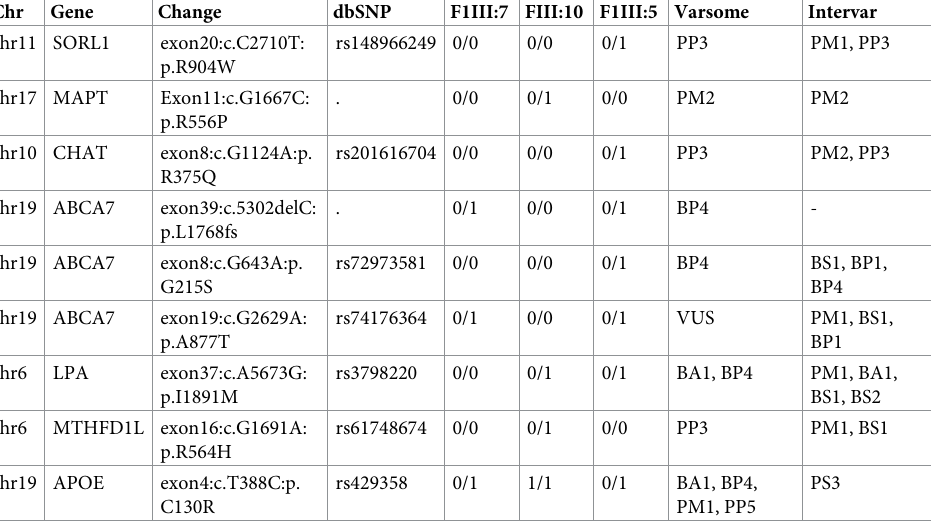
Table 3. Clinical interpretation of the candidate variants identified in the exome analysis in a family with Familial Alzheimer’s Disease.